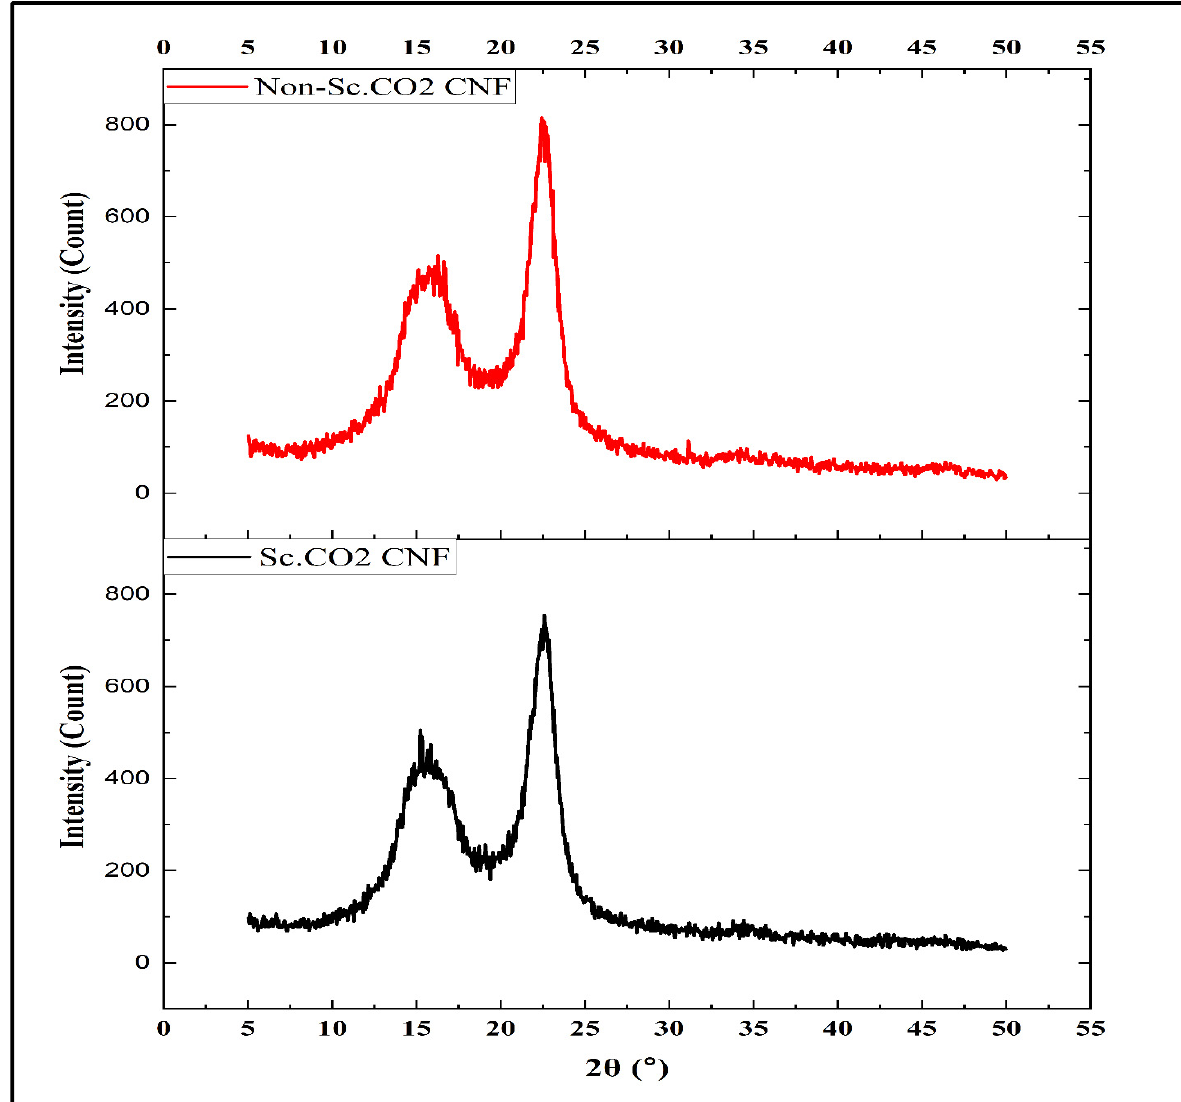
Figure 6. X-ray diffractograms of Sc.CO 2 and non-Sc.CO 2 obtained CNFs.